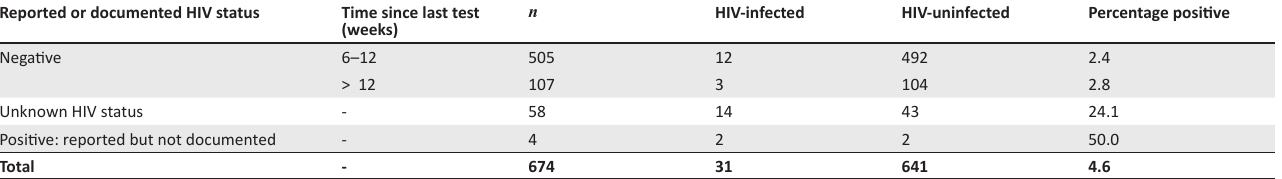
TABLE 1: HIV status of post-partum women prior to enrolment and after testing with the National testing algorithm. Reported or documented HIV status